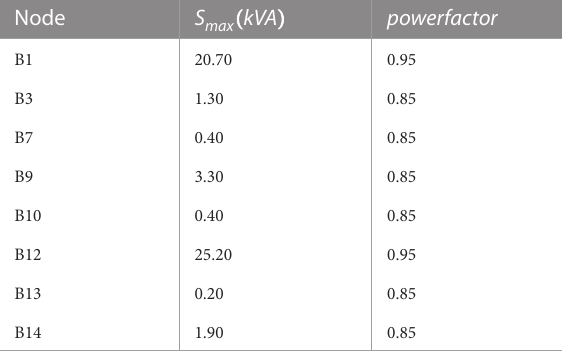
TABLE3 MVdistributionnetworkbenchmarkapplication:Parameters ofcommercialload.